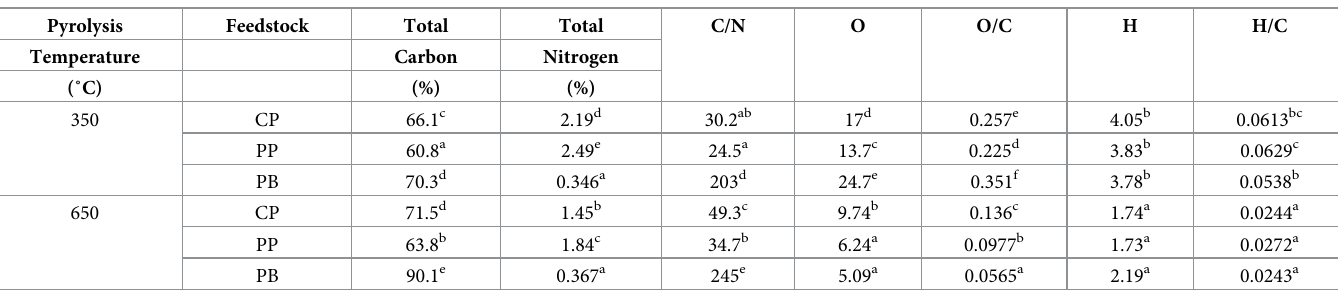
Table 4. Ultimate results of the biochars.